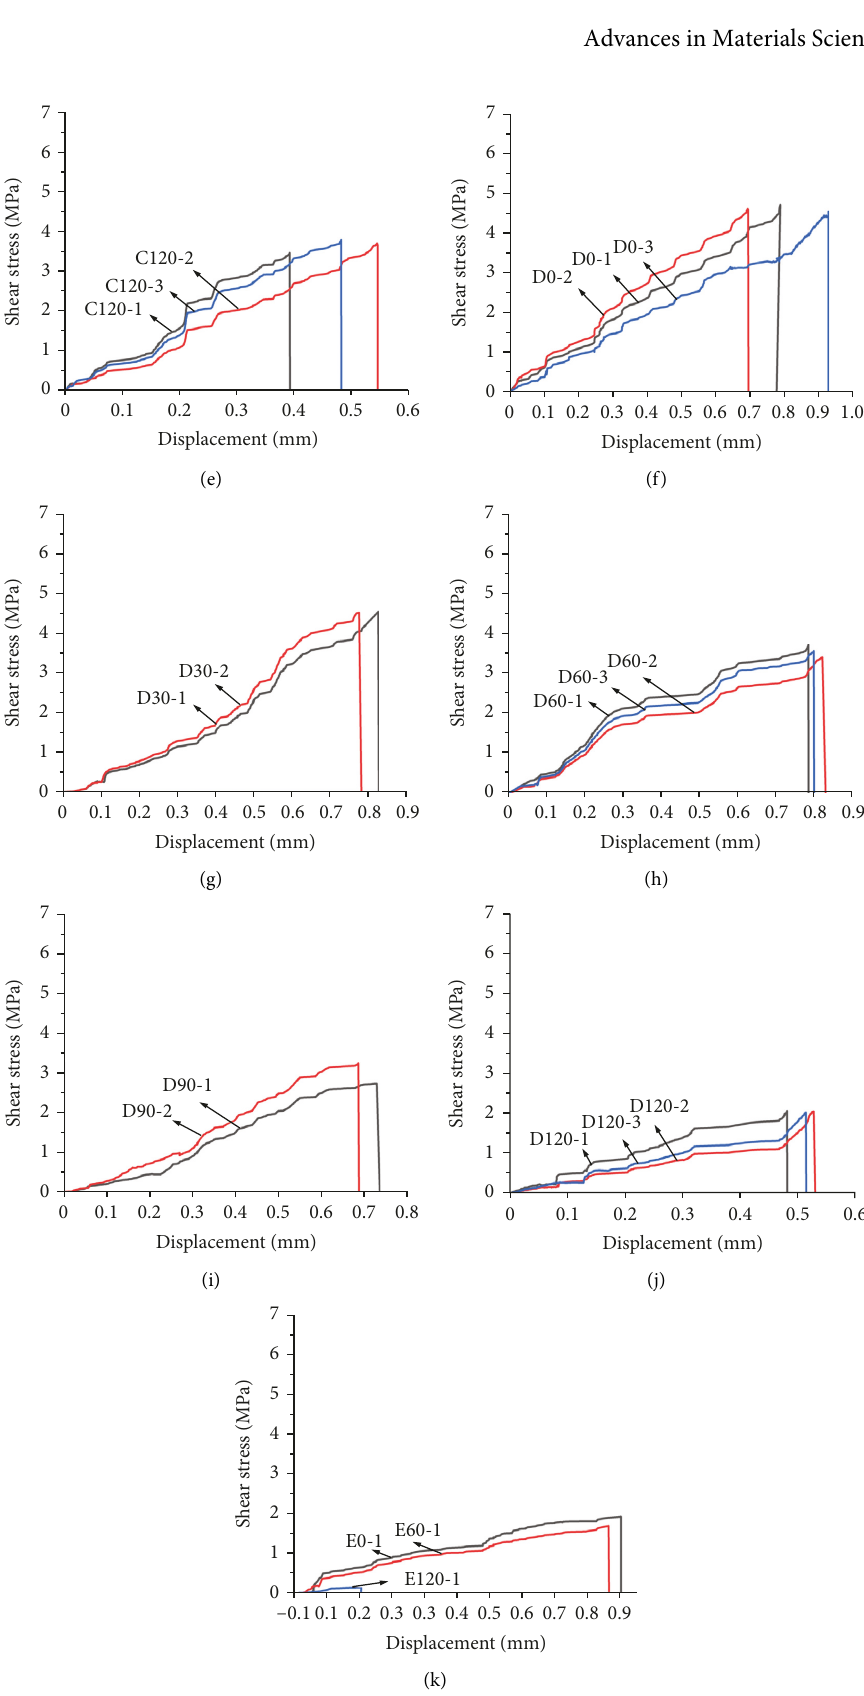
Figure 5: Shear stress-displacement curves under different conditions. (a) 25 ° C. (b) 100 ° C, 120 min. (c) 150 ° C, 0min. (d) 150 ° C, 60min. (e) 150 ° C, 120min. (f) 200 ° C, 0min. (g) 200 ° C, 30min. (h) 200 ° C, 60min. (i) 200 ° C, 90min. (j) 200 ° C, 120min. (k) 300 °